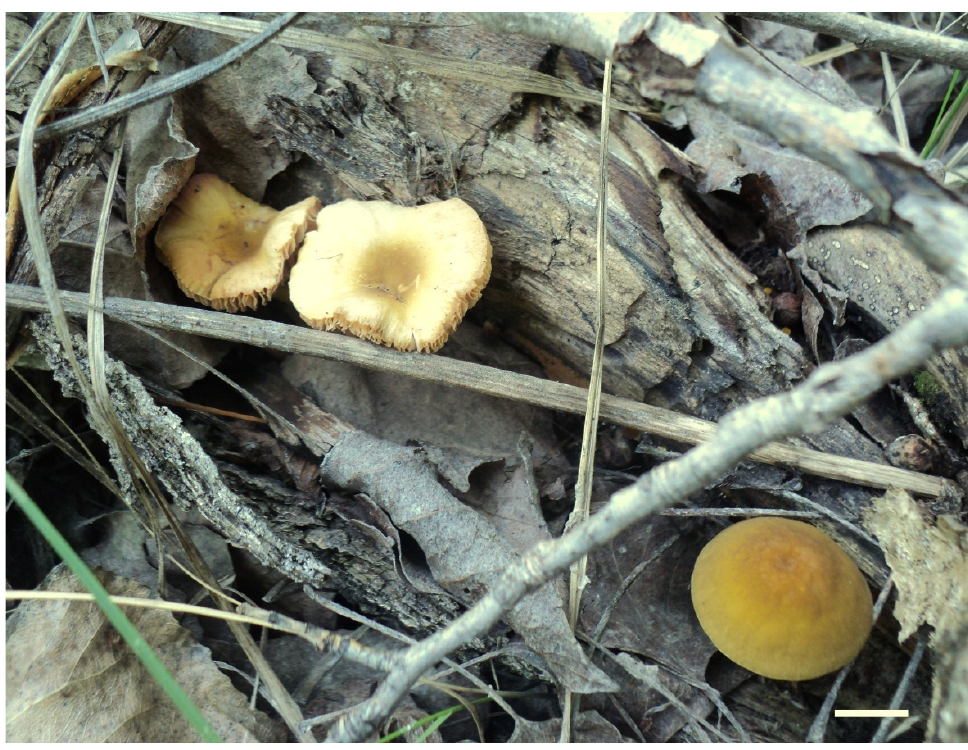
Figure 18. Pluteus siccus basidioma of holotype LE 313356 in situ. Scale bar 1 cm.